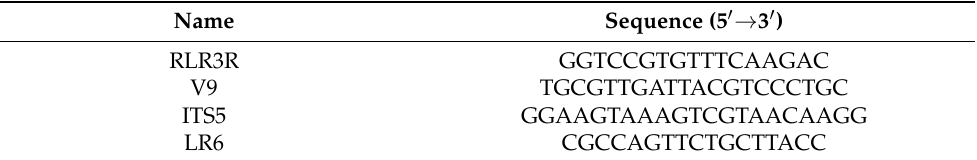
Table 4. Sequences of primers used for taxonomic identification of psychrophilic strain